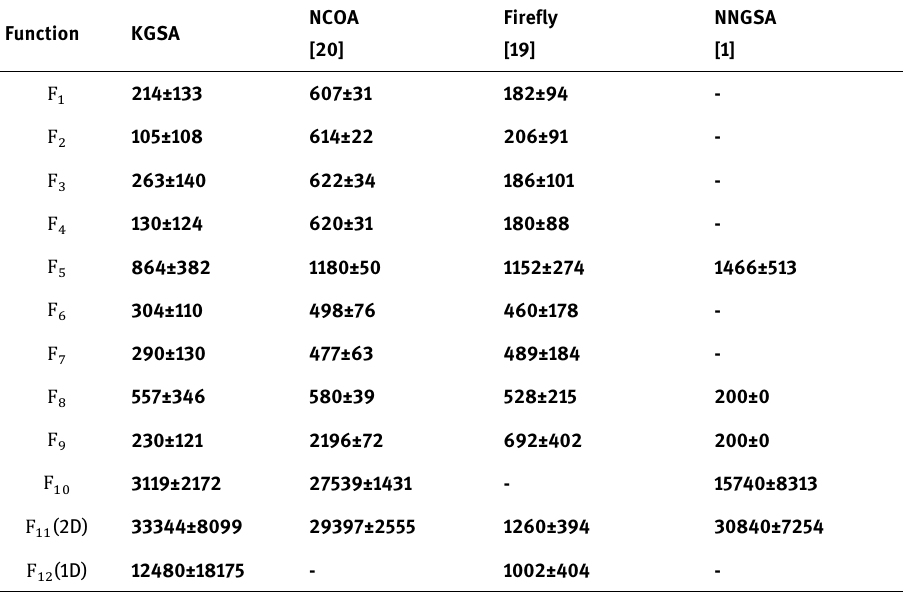
Table 4A: Average number of fitness function evaluations required to converge for each of the evolutionary algorithms. The results were averaged over fifty independent runs of